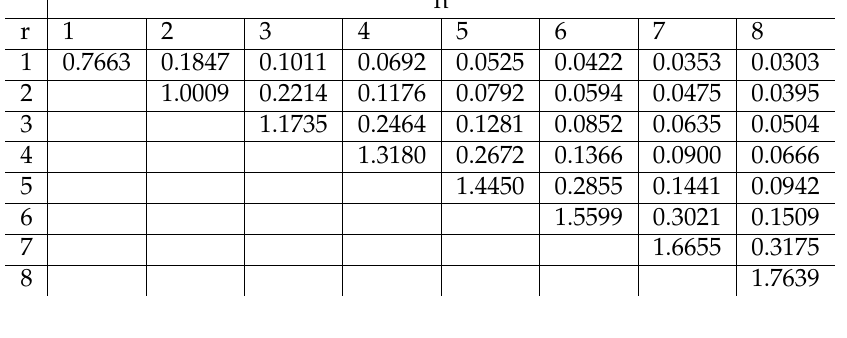
Table 3. Means of gos from Pareto-Rayleigh distribution( α =2, σ =1, m =1, k =2)